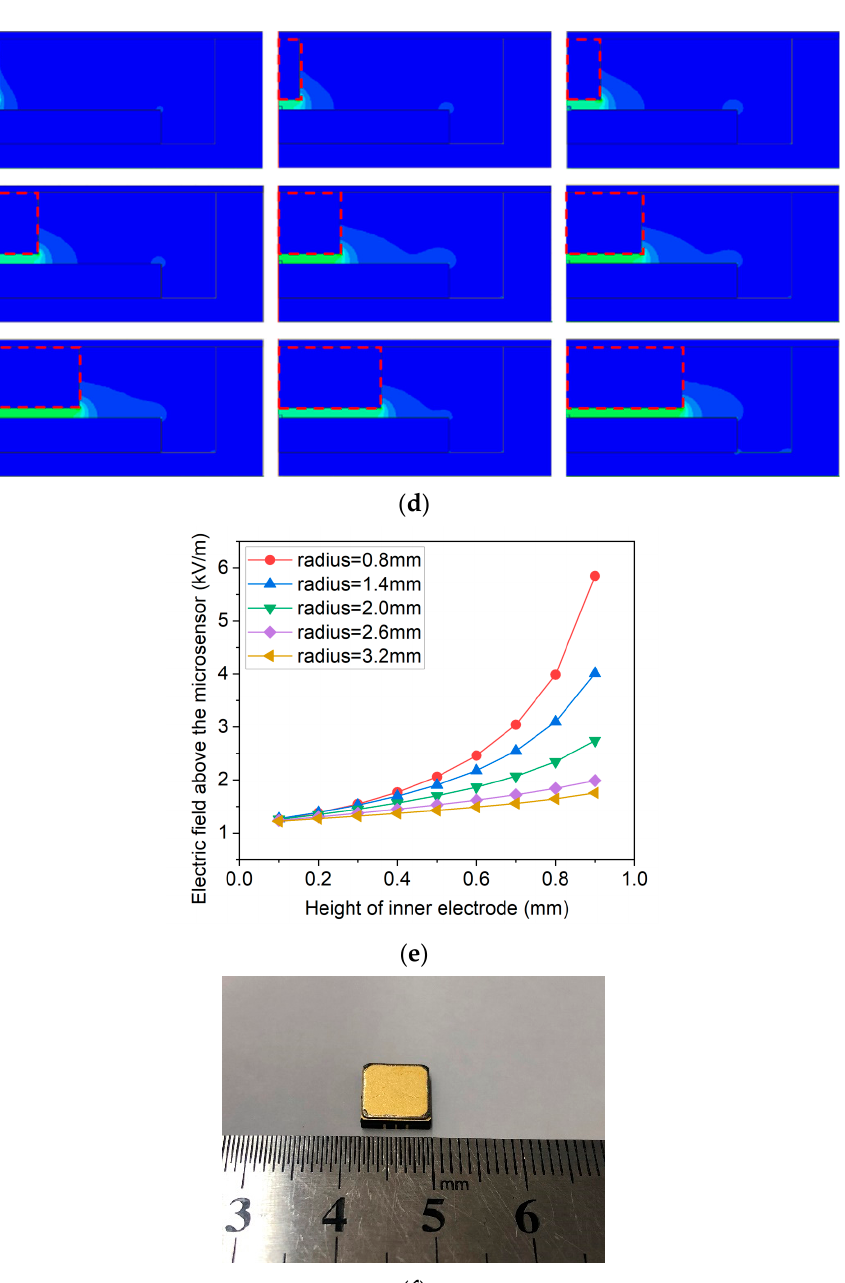
Figure 2. Package design of the electric field microchip. ( a ) Mathematical analysis model of the microsensor package. The model only includes the package cap and the microchip while the package shell and the gold wires are neglected to simplify the calculation. ( b ) Electric field nephogram simulation results on the enhancement effect of package. ( c ) Field nephogram comparison when the height of the inner electrode changed from 0.1 mm to 0.9 mm. ( d ) Field nephogram comparison when the width of the inner electrode changed from 0.1 mm to 1.7 mm. ( e ) Simulated results of the relationship between the dimensions and the electric field. We changed the radius and the height of the inner electrode, and meanwhile a small air dome was created to read the electric field above the microsensor. ( f ) Picture of the sealed cavity using ceram material as the package shell, and covar as the package cap. Total size of the packaged chip is 8 mm × 8 mm × 2 mm.